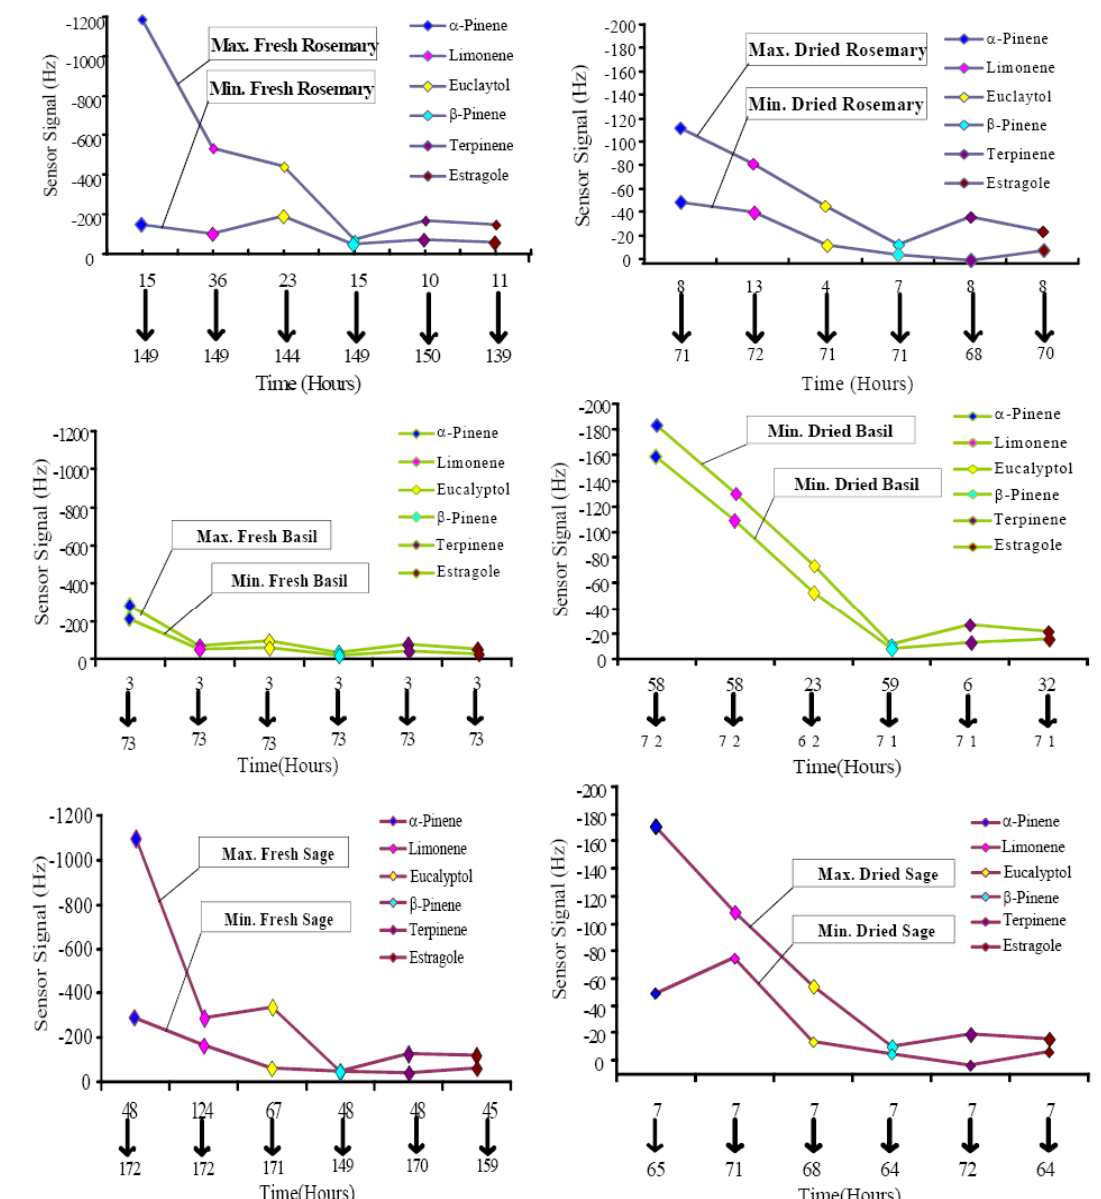
Figure 8. Comparison of maximum and minimum